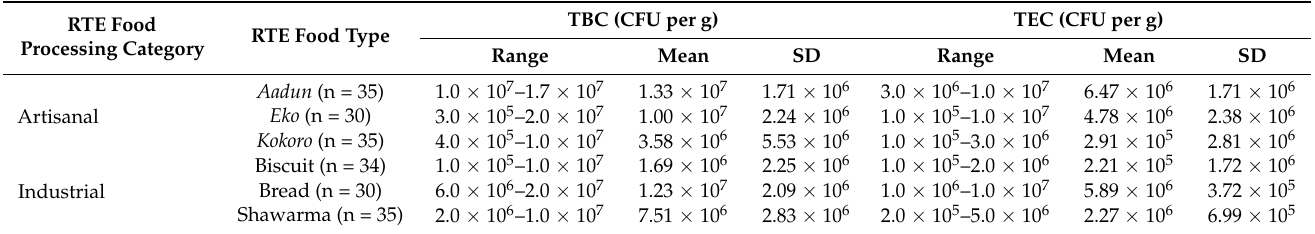
Table 1. Total bacterial count (TBC) and total enterobacterial count (TEC) in vended ready-to eat foods in Lagos,